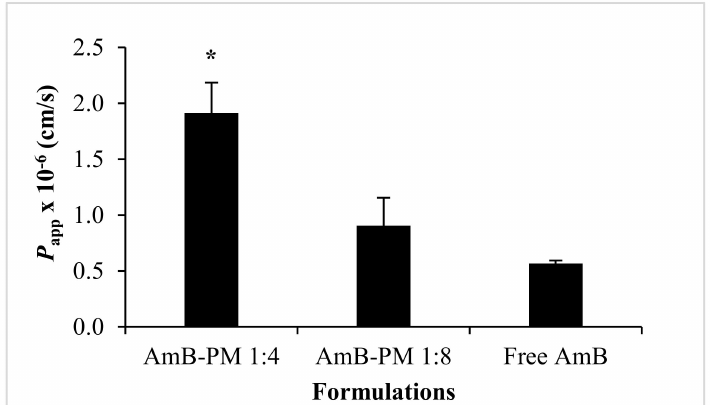
Figure 7. The corresponding P app values of AmB-PM across the Caco-2 cell monolayer. Data are presented as mean ± SD, ( n = 3). * indicate statistically significant di ff erences between groups ( p <